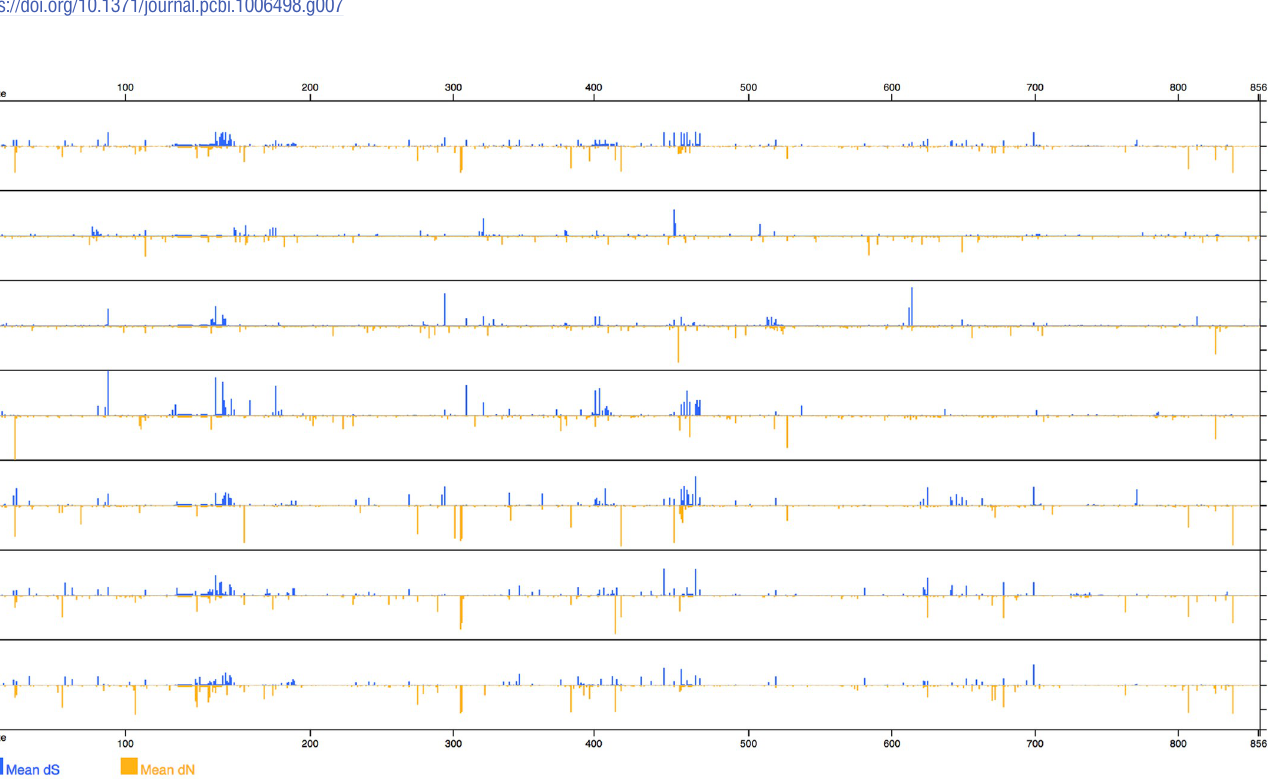
Fig 8. Screenshot of dN / dS values mapped to protein positions and separated by time